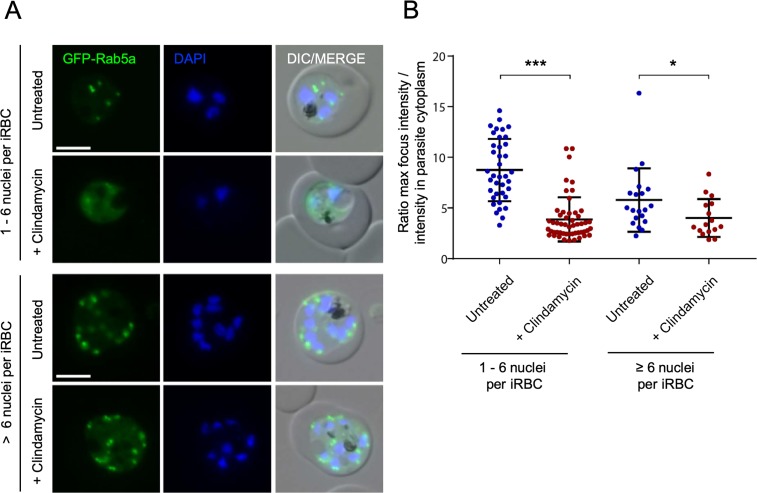
Rab5a shows an aberrant localisation in the second IDC after clindamycin treatment.(A) Representative live-cell images of untreated and clindamycin (5 μM) treated parasites in the second IDC following treatment are shown. Cell populations were divided into parasites with 6 or fewer nuclei (upper panel) and parasite with more than 6 nuclei (lower panel), as the disruption is clearly most pronounced in trophozoite stage parasites. GFP-Rab5a, green signal; DAPI: parasite nuclei, blue signal; merge of green and blue signal. Scale bar = 5 μm. (B) Graph showing the ratio of the brightest GFP focus fluorescence intensity to mean fluorescence intensity distributed in the parasite cytoplasm in untreated and clindamycin treated parasites. N = 38 for untreated, 1–6 nuclei; n = 52 for + clindamycin, 1–6 nuclei; n = 20 for control, > 6 nuclei and n = 16 for + clindamycin, > 6 nuclei. *P < 0.05; ***P < 0.001, Welch t test. Scatter dot plots show error bars with mean ± SD. See S2 Data for numerical data underlying figure. DAPI, 4′,6-diamidino-2-phenylindole; DIC, differential interference contrast; GFP, green fluorescent protein; IDC, intraerythrocytic developmental cycle; iRBC, infected red blood cell.